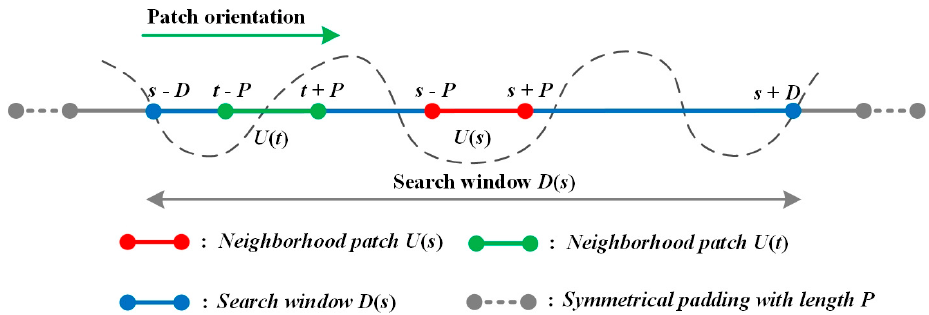
Figure 2. Illustration of the NLPR execution. The half − width of the blue search window is D . The half − width of neighborhood patches is P , which is equal to the length of the symmetric padding patches.